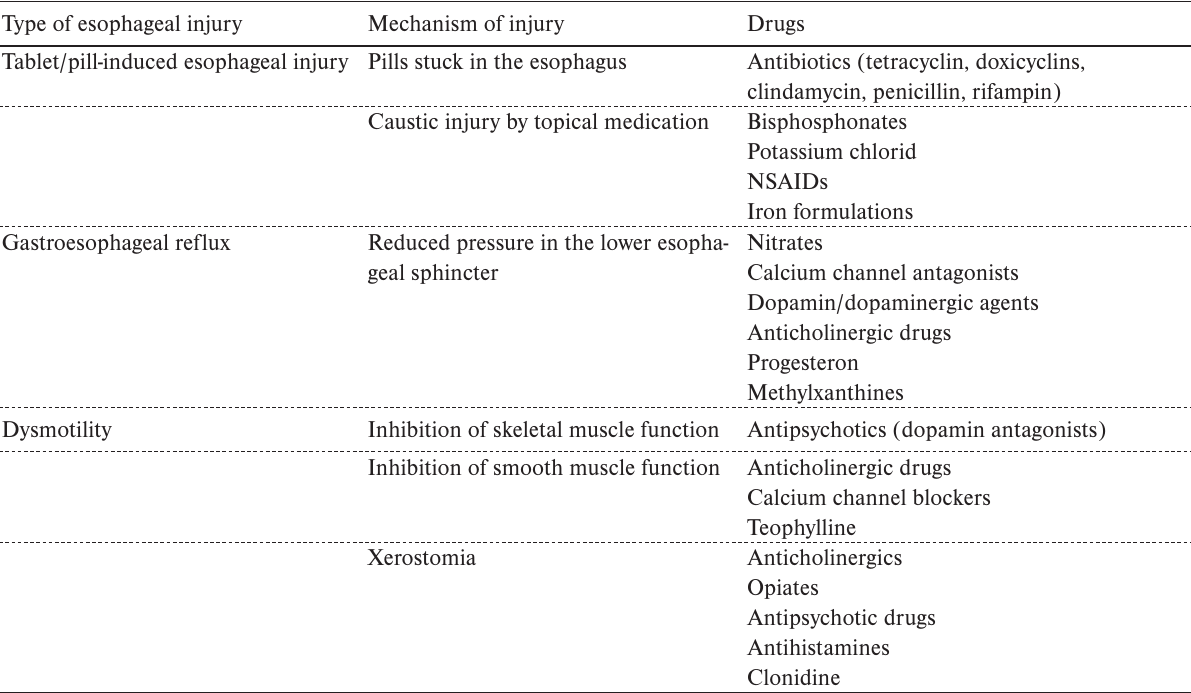
Table 1. Adverse drug effects on the